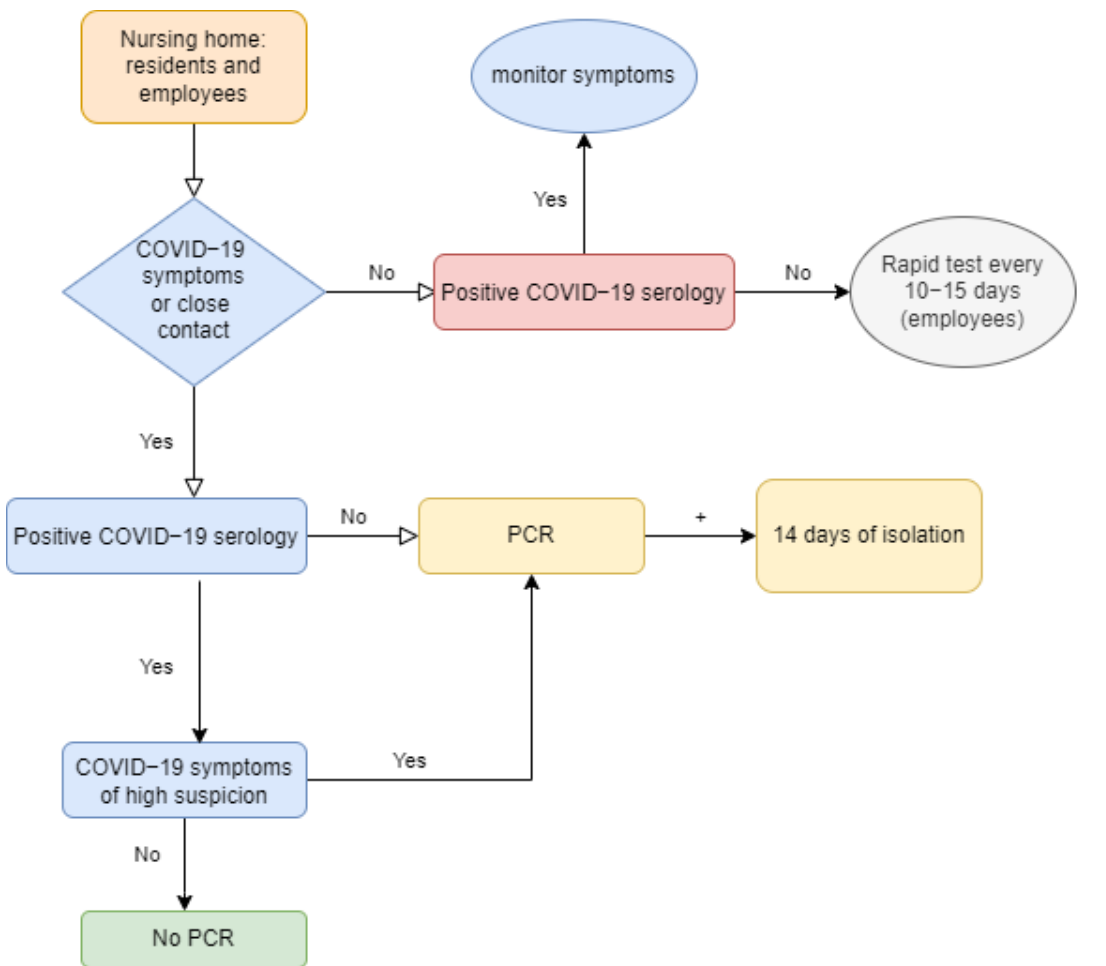
Figure 1. S uspected cases of COVID-19, recommendations of the Spanish Ministry of Health in 2020.